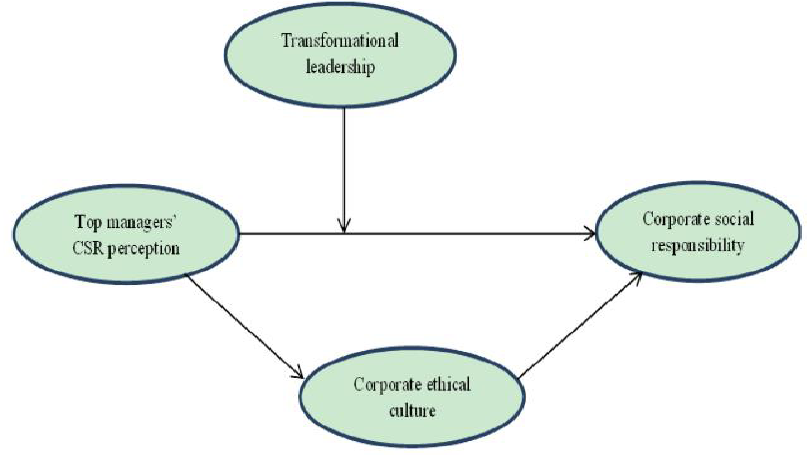
Fig. 1 Concept framework of the